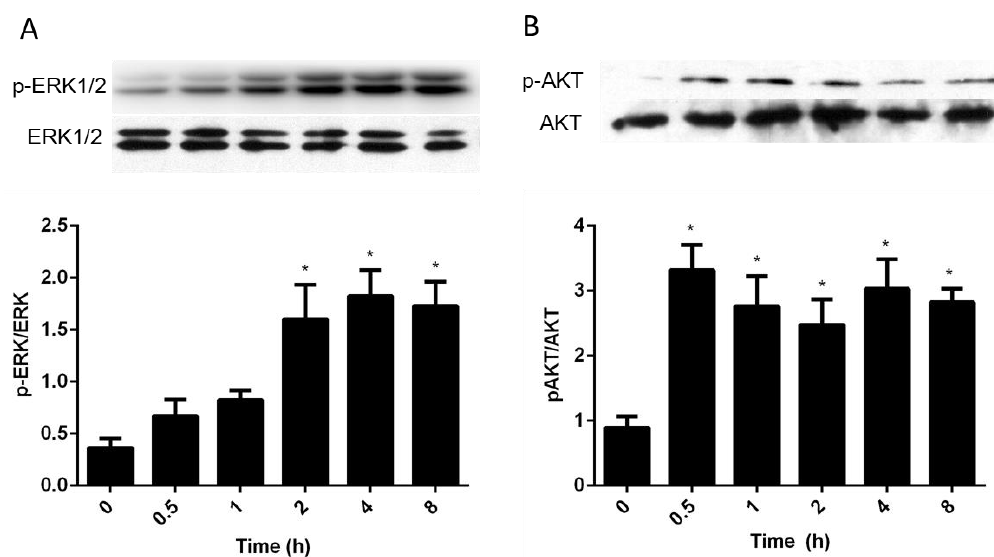
Figure 6. E ff ects of AA on the regulation of ERK1 / 2 and AKT phosphorylation in granulosa cells. Bovine granulosa cells were cultured in serum-free medium for three days and then treated with 50 µ M AA for the times given. Phosphorylation of ERK1 / 2 ( A ) and AKT ( B ) in response to AA was measured by Western blot. Data are mean ± SEM of three independent replicates. * indicates significantly di ff erent from time 0 ( p < 0.05).